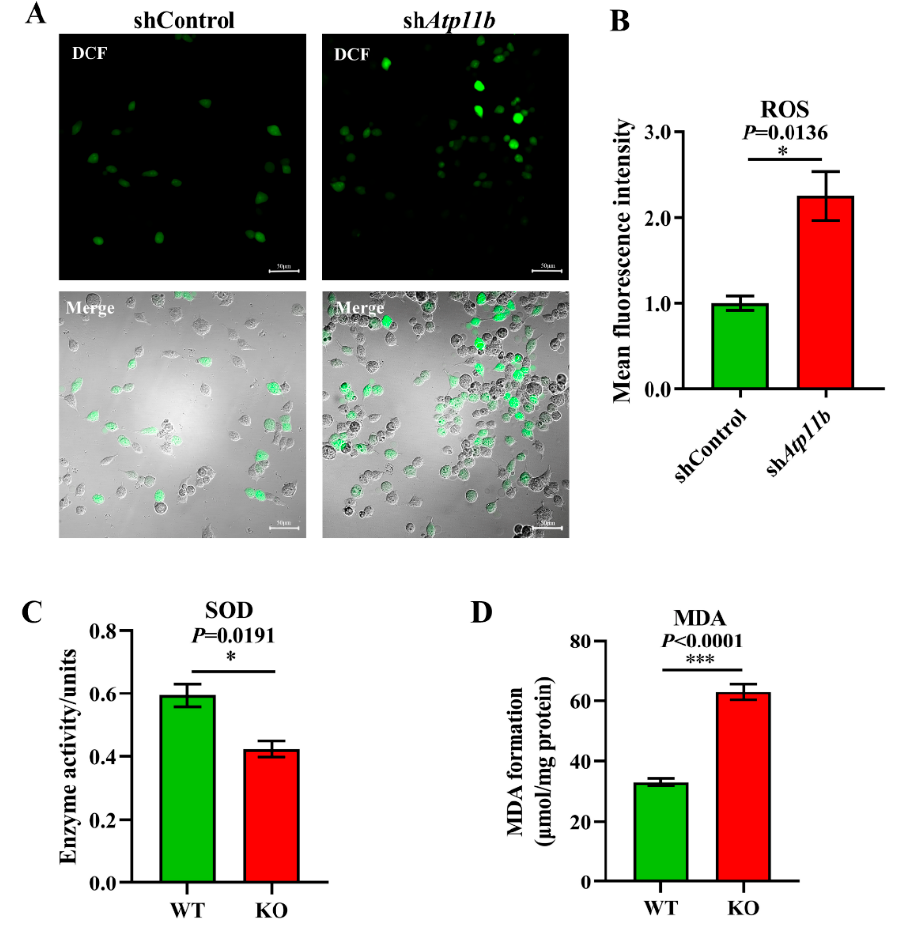
Figure 3. Deficiency in Atp11b weakens the antioxidant capacity and enhances the oxidative stress response. ( A ) SH-SY5Y cells were transfected with the corresponding plasmids, and, after 36 h, DCFH-DA was used as a probe to generate DCF for the quantitation of cellular ROS levels; scale bars: 50 µ m. ( B ) The average fluorescence intensity of the generated DCF in SH-SY5Y cells of the two groups was calculated to measure the level of ROS. For each group of cells, n = 3. ( C ) Assay of the total SOD activity in the hippocampus of mice. For each group of mice, n = 3. ( D ) Determination of MDA levels in the hippocampus of mice. For each group of mice, n = 4. The mice were 12 months old. Data are expressed as the mean ± SEM. Student’s t -test, * p < 0.05 and *** p < 0.001. 3.4. The Cell Number in the Hippocampal DG Region of Atp11b-KO Mice Is